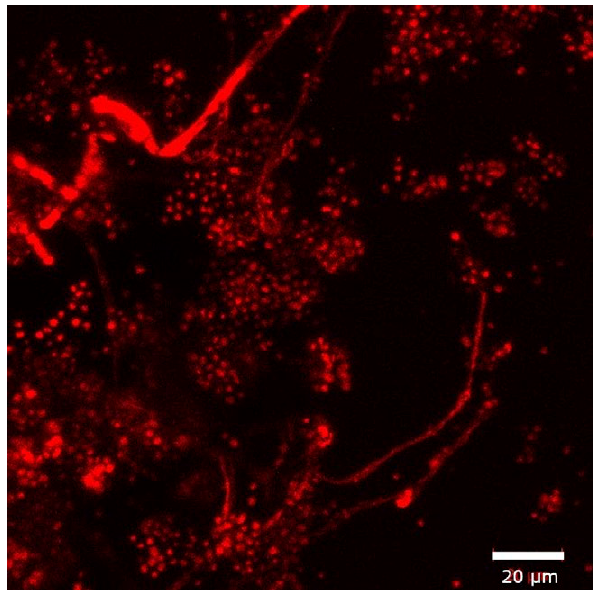
Figure 2. Confocal microscope image of Trichoderma atroviride T-77:: tdTomato mycelia and